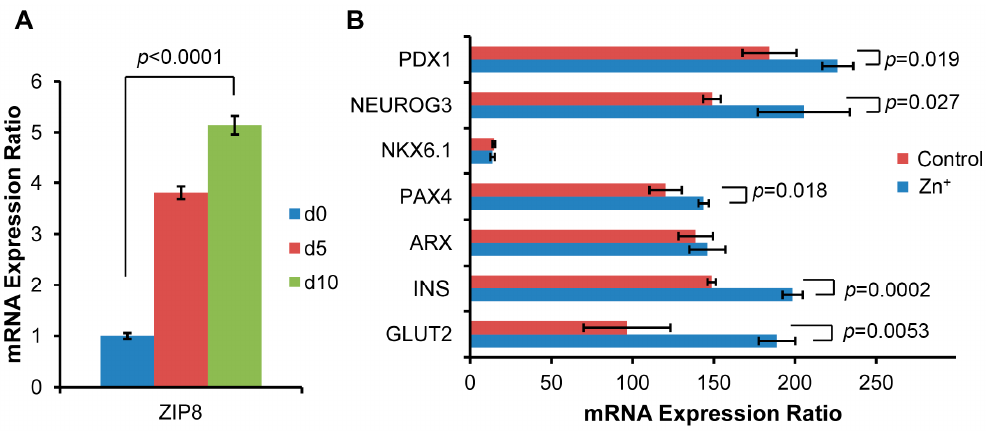
Figure 3. mRNA level changes in Zrt- and irt-like protein 8 (ZIP8) expression and β cell differentiation markers. ( A ) ZIP8 expression increased between d0 and d10; ( B ) Zinc supplementation at d10 increased the levels of most markers, particularly Insulin and GLUT2. n = 3.